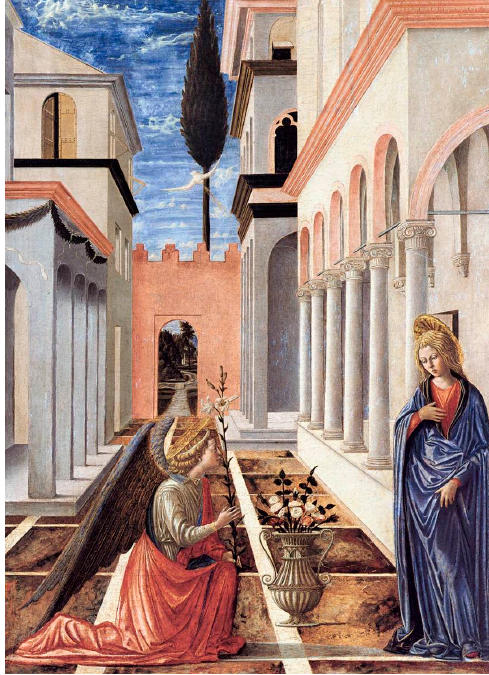
Figure 9. Fra Carnevale, The Annunciation , c. 1448. The National Gallery of Art, Washington, DC.